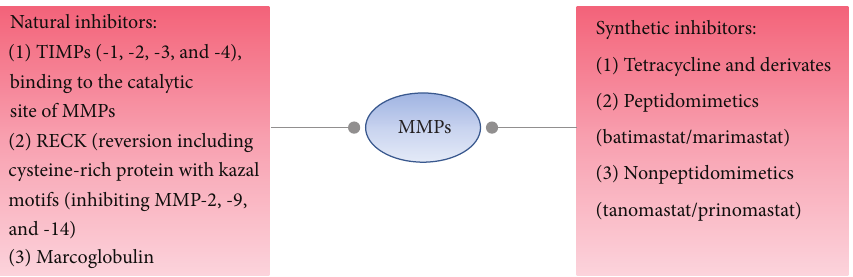
Figure 1: MMP inhibition is possible by targeted natural as well as synthetic inhibitors. References: Visse and Nagase [18]; Oh et al. [201]; Coussens et al. [202]; Overall and L´opez-Ot´ın